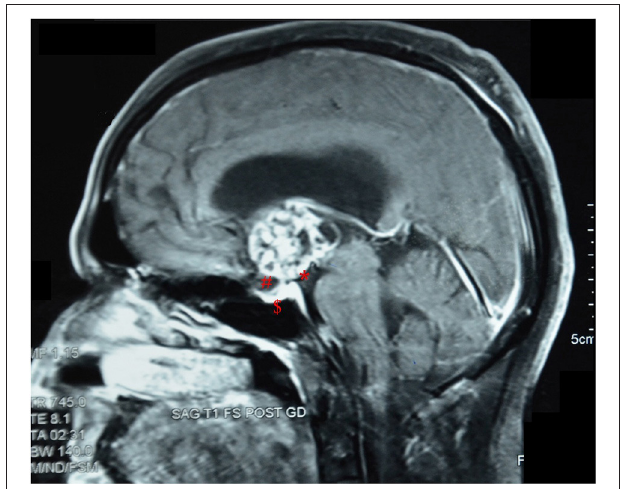
FIGURE 2 | Post-contrast sagittal MRI image of a patient with an intrinsic third ventricular craniopharyngioma, showing features as described by Migliore et al. (16). *, an intact third ventricular floor; #, a patent suprasellar cistern; $, absence of sellar